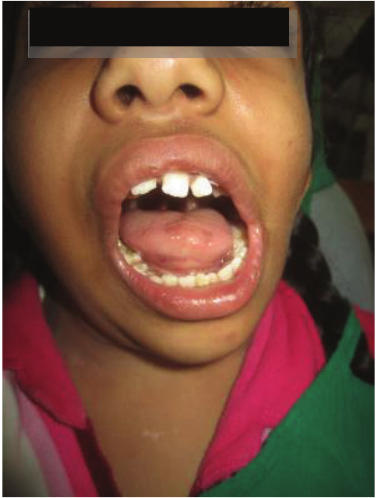
Figure 1: Frontal view.